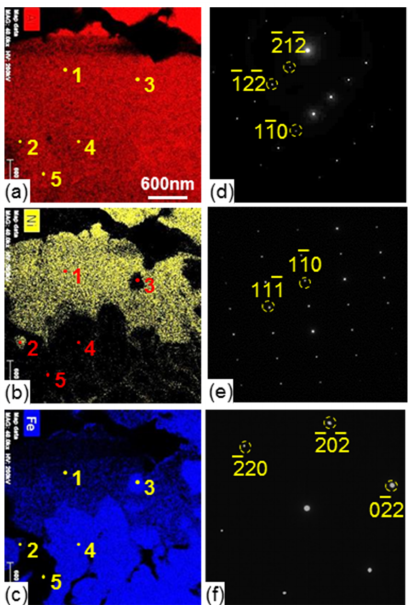
Figure 6. ( a – c ) Results of the EDS analysis of Figure 5d: ( a ) Al, ( b ) Ni, and ( c ) Fe. ( d – f ) Characteristic SAED patterns and their key diagrams taken from the phases denoted as 1–5 in Figure 5d: ( d ) 1, 2: Z.A [223], Al9FeNi (T); ( e ) 3, 4: Z.A [112], Fe2Al5 ( η ); and ( f ) 5: Z.A [111], Al. (Zone axis: Z.A). Scale bar: 600